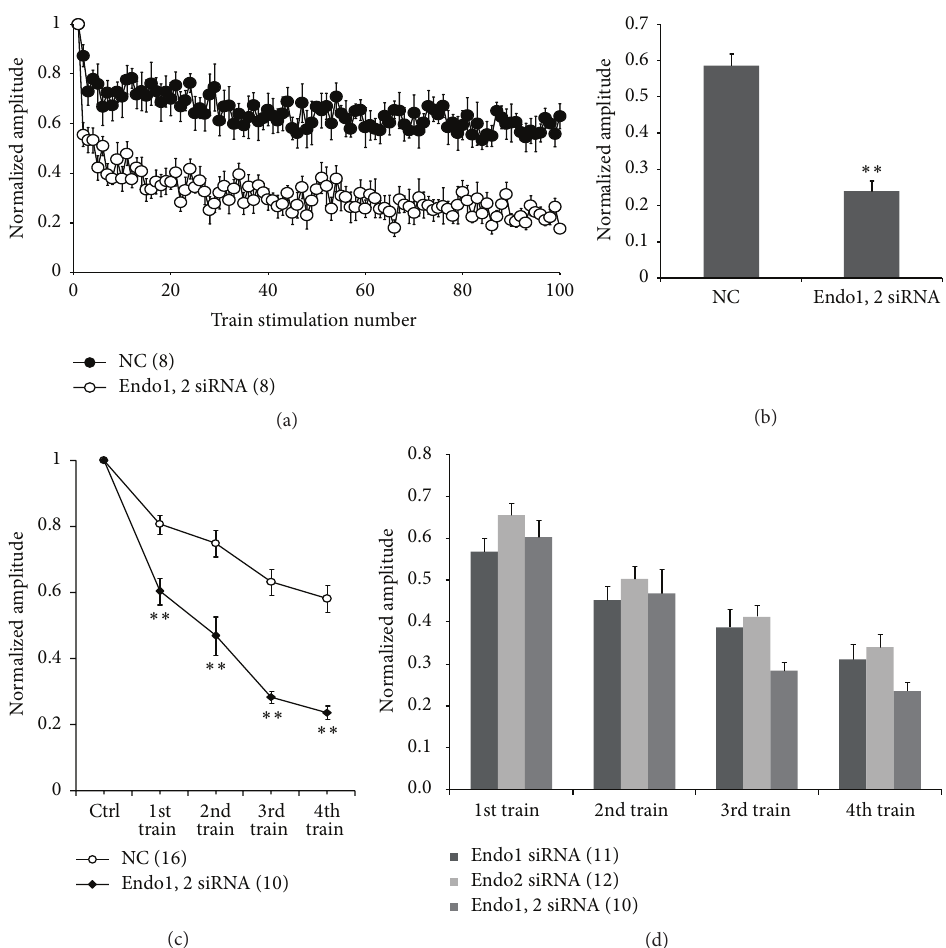
Figure 4: Quantitative analysis of sustained neurotransmitter release in endophilin1, endophilin2 (Endo1, 2) double-knockdown neurons. (a) Changesinshort-termsynapticdepression(STD)innontransfectedneuronsevokedby100pulsesat5 HzinneuronscotransfectedwithEndo1 and Endo2 siRNAs ( 𝑛 = 8 ). (b) Average normalized amplitude of the last 20 responses in Endo1, 2 siRNA-transfected and scrambled negative control- (NC-) transfected neurons; 𝑛 = 8 , ∗∗ 𝑝 < 0.005 . (c) Normalized amplitude of excitatory postsynaptic currents (EPSCs) evoked by multiple train stimulation in neurons transfected with control or Endo1, 2 siRNA; ∗∗ 𝑝 < 0.005 . (d) Normalized amplitudes compared